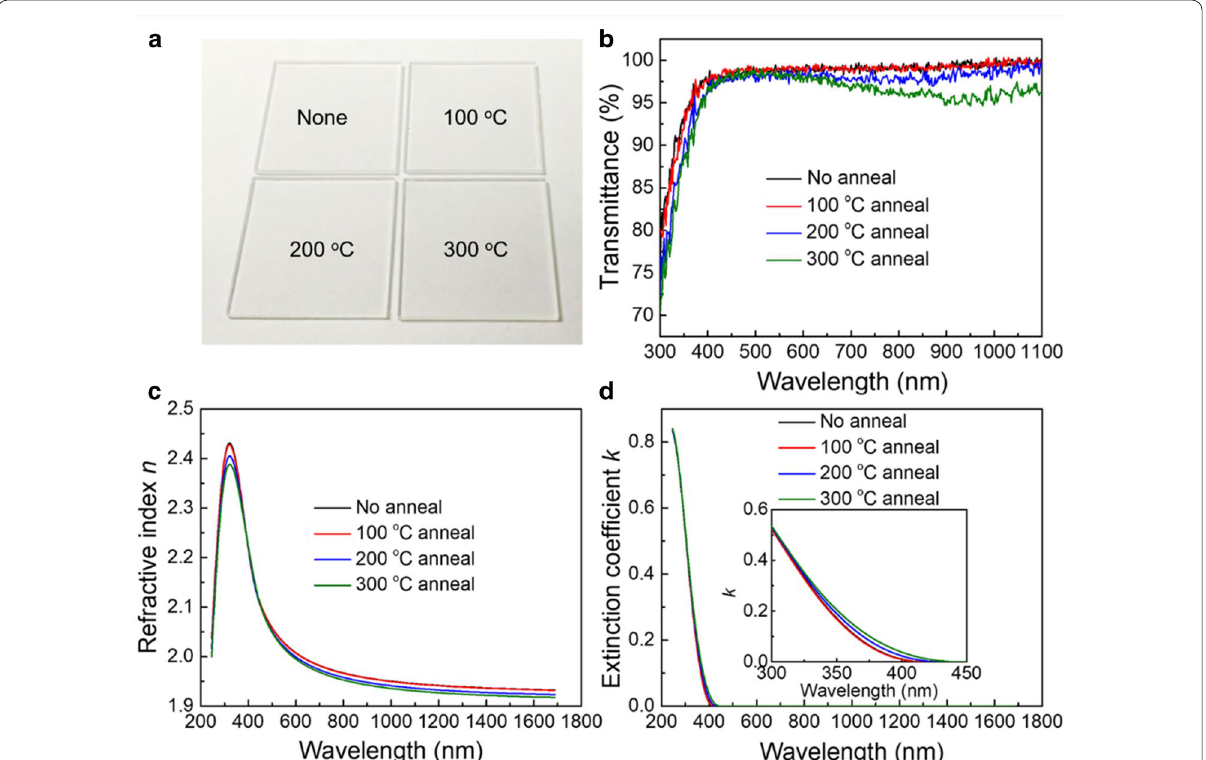
Fig. 1 a Photographs and b transmittance spectra of the 10-nm-thick MoO X films on silica glass annealed in air for 5 min at different temperatures. c Refractive indices n and d extinction coefficient k curves of the 20-nm-thick MoO X films on polished silicon wafers